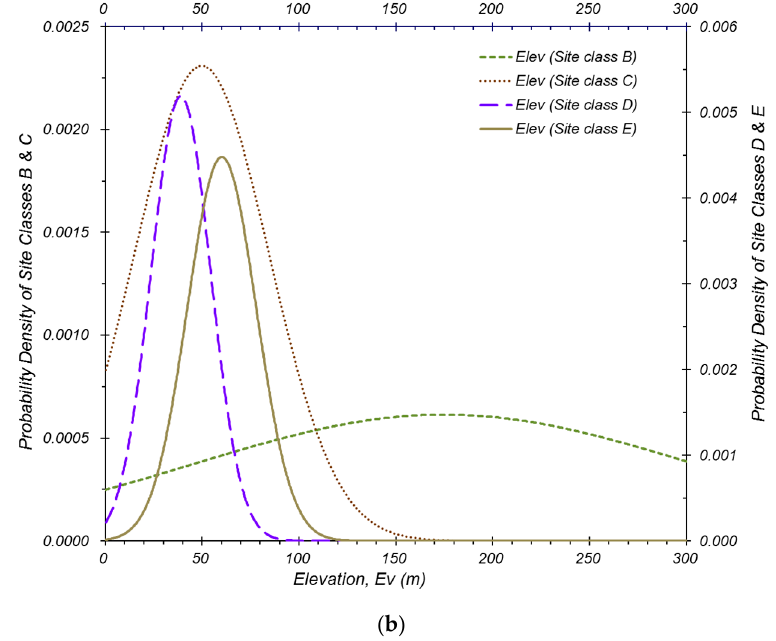
Figure 7. Logarithmic normal probability distribution of geo-proxies for each site classification condition according to T G in Seoul: ( a ) surface terrain slope; ( b ) surface elevation.